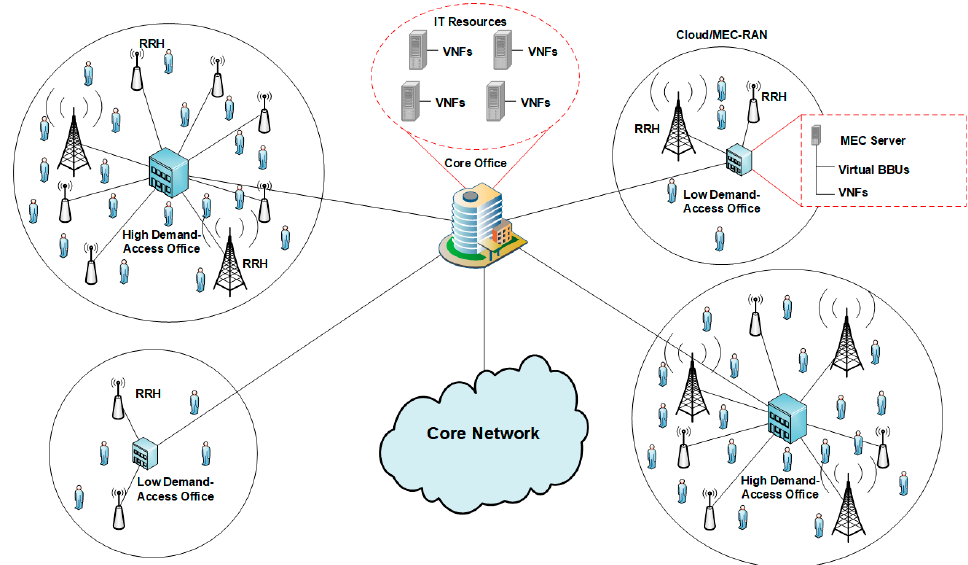
Figure 1. Proposed 5G architecture implementing Cloud/ Mobile Edge Computing (MEC) Radio Access Networks (RAN).